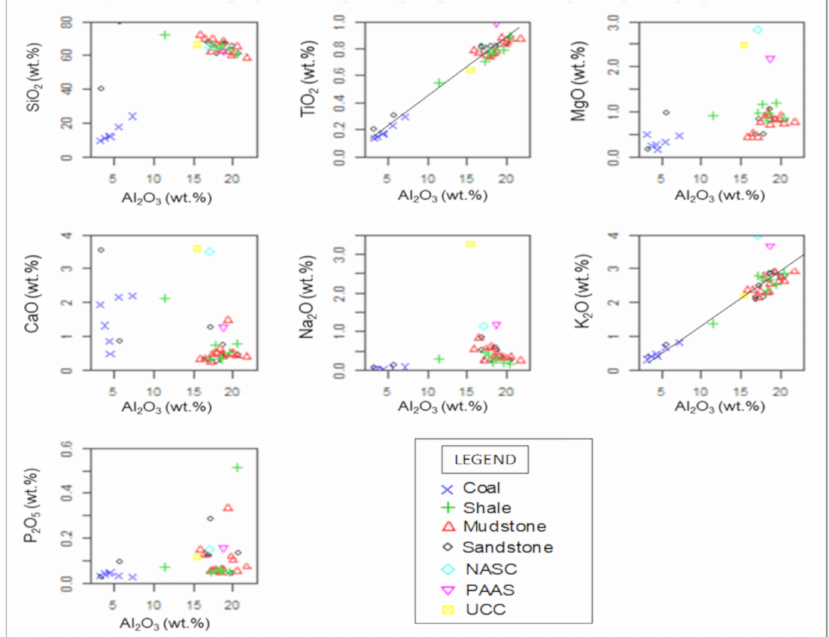
Figure 6. Bivariate plot of major oxides against Al 2 O 3 showing the distribution of shale and coal samples from the Madzaringwe Formation. Average data of UCC, NASC, and PAAS extracted from [5,25,26], respectively are plotted for